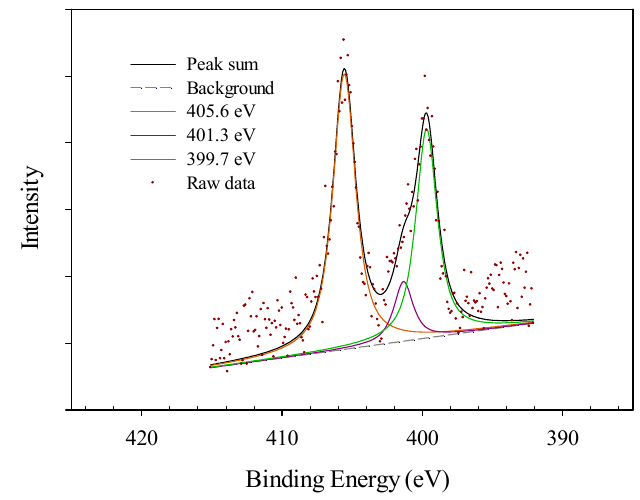
Figure 7. XPS spectra of nitrogen 1s peak for nitric acid-treated AF 5.